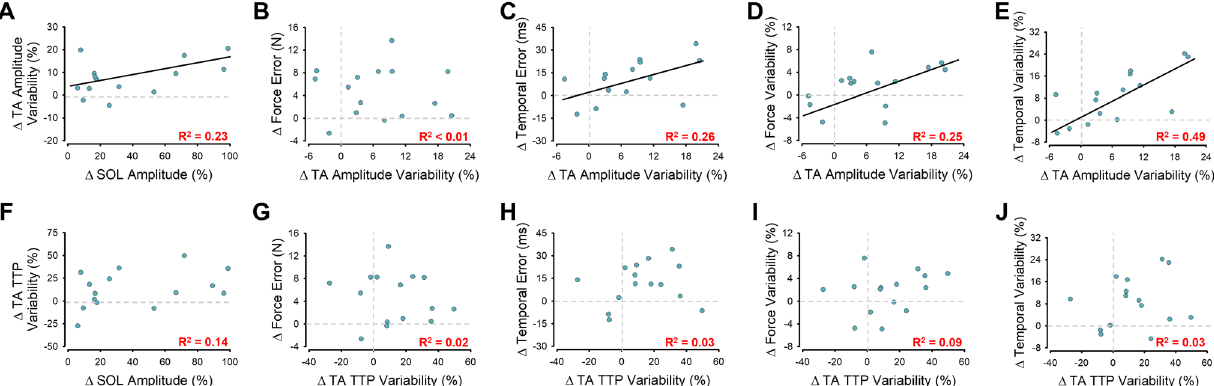
Figure 8. TA muscle activity associations with SOL muscle activity and endpoint control for young adults using a Low SOL and High SOL coordination pattern. Upon removal of an outlier, the association between the change in SOL muscle activity with the change in TA amplitude variability becomes significant ( A ). Consequently, the change in TA amplitude variability did not significantly associate with the change in force error ( B ) but significantly and positively associated with temporal error ( C ), force variability ( D ) and temporal variability ( E ). In contrast, the change in SOL muscle activity did not associate with the change in TA time-to-peak (TTP) variability ( F ) and the change in TA TTP variability did not associate with any measures of endpoint control ( G – J